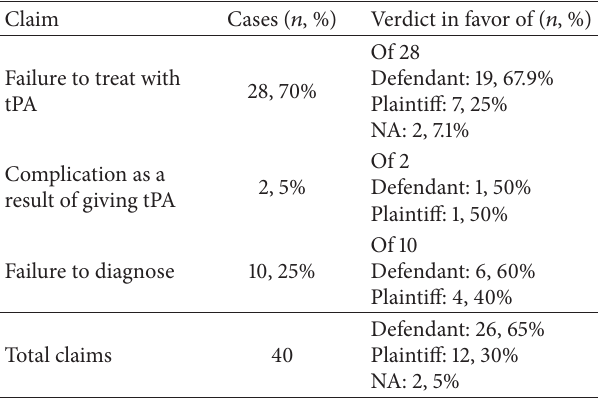
Table 1: Malpractice